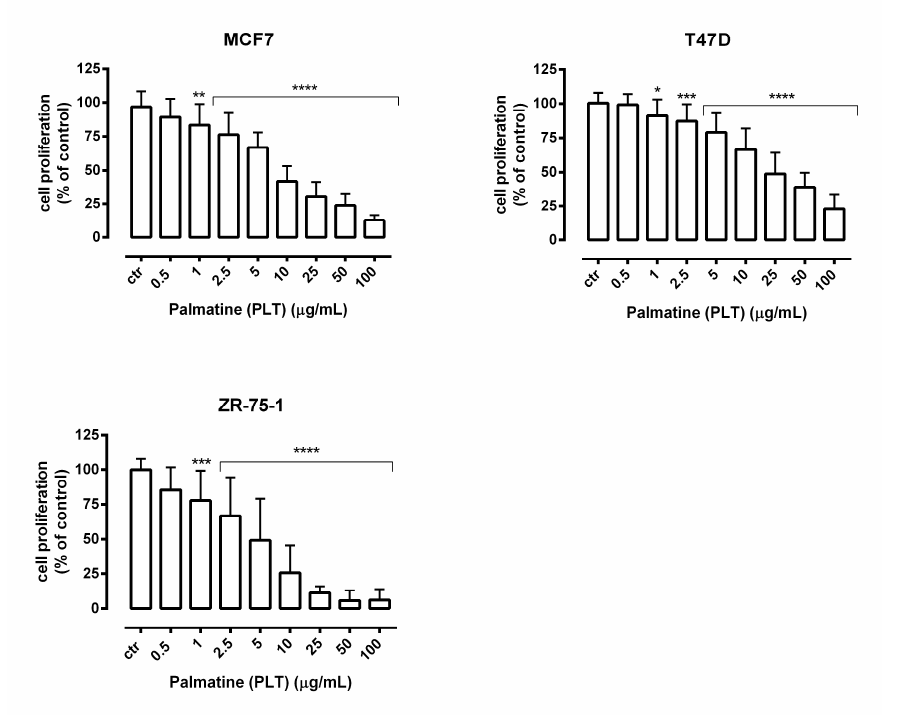
Figure 5. The effect of palmatine (PLT) on the proliferation of human breast cancer cell lines was measured by BrdU assay after 72 h. Results are presented as mean ± SEM at each concentration. (* p < 0.05; ** p < 0.01; *** p < 0.001, **** p < 0.0001), n = 16 per concentration from two independent